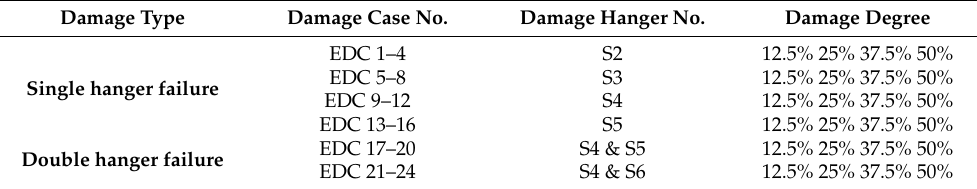
Table 5. Twenty-four damage conditions considered by the test model.